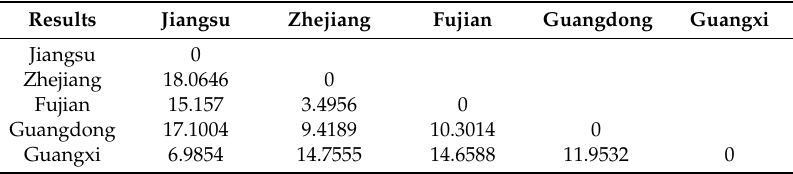
Table 4. Estimated dispersion among China’s five main coastal provinces.